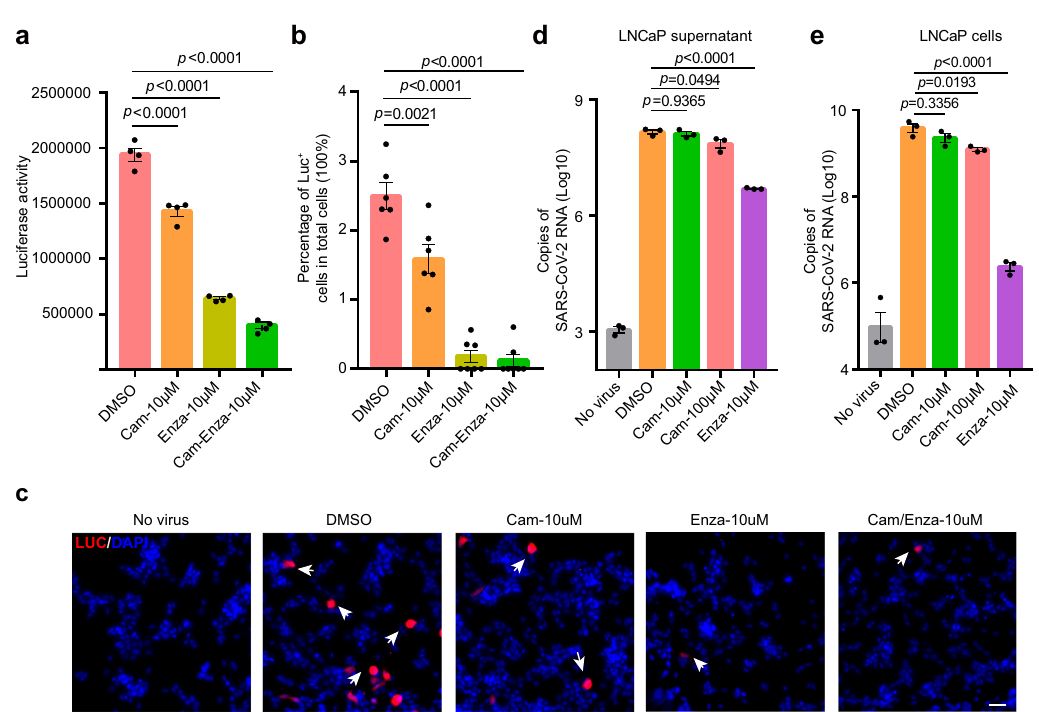
Fig. 1 Ad-ACE2-transduced Tmprss2-KO mice demonstrates TMPRSS2 as an important factor for SARS-CoV-2 infection. a H&E staining of WT and Tmprss2-KO mouse lungs. b YFP IHC staining for lungs, kidneys, livers, and prostates of T2Y mice with (bottom) or without (top) tamoxifen administration. Red arrow indicates alveoli cells and green arrow indicates bronchiole cells, respectively. c Experimental strategy to identify the role of TMPRSS2 in mediating SARS-CoV-2 infection utilizing Ad-ACE2-transduced mouse models. d The percentage of body weight post SARS-CoV-2 infection in initial body weight (two-tailed t -test, mean ± SEM, n = 7 (day 0), n = 7 (day 1), n = 4 (day 2), n = 3 (day 3), n = 3 (day 4), n = 3 (day 5), and n = 3 (day 6) biologically independent mice for wild type group, n = 10 (day 0), n = 10 (day 1), n = 5 (day 2), n = 5 (day 3), n = 5 (day 4), n = 5 (day 5), and n = 5 (day 6) biologically independent mice for Tmprss2-KO group) . e Viral loads of SARS-CoV-2 in the lungs of WT and Tmprss2-KO mice (two-tailed t -test, mean ± SEM, n = 5 biologically independent mice). f S protein IHC staining for lungs of Ad-ACE2-transduced wild type mice with (left) or without (right) SARS-CoV-2 challenge and Ad-ACE2-transduced Tmprss2-KO mice (middle) with SARS-CoV-2 challenge, respectively. g Quanti fi cation of lung cells with SARS-CoV-2 infection indicated by S protein IHC staining (two-tailed t -test, mean ± SEM, n = 5 biologically independent mice). h H&E staining of lungs from Ad-ACE2-transduced WT mice challenged with (left) or without (right) SARS-CoV-2 and Ad-ACE2-transduced Tmprss2-KO mice (middle) challenged with SARS-CoV-2, respectively. i Immuno fl uorescence staining for CD45 in the lungs of Ad-ACE2-transduced wild type mice with (left) or without (right) SARS-CoV-2 challenge and Ad-ACE2-transduced Tmprss2-KO mice (middle) with SARS-CoV-2 challenge, respectively. j Quanti fi cation for CD45-positive cells in total cells (two-tailed t -test, mean ± SEM, n = 5 biologically independent mice for wild type group and n = 3 biologically independent mice for Tmprss2-KO group). k – n qRT-PCR analyses on mRNA expression of Il6 ( k ) , Cxcl10 ( l ), Ifnb ( m ), and Ifng ( n ) in the lungs of WT and Tmprss2-KO mice challenged by SARS-CoV-2 (two-tailed t -test, mean ± SEM, n = 6 biologically independent mice for wild type group and n = 5 biologically independent mice for Tmprss2-KO group respectively). o H&E score quanti fi cation for lung lesions in WT mice and Tmprss2-KO mice (Mann – Whitney test, mean ± SEM, n = 6 biologically independent mice for wild type group and n = 5 biologically independent mice for Tmprss2-KO group). Scale bars represent 50 μ m.